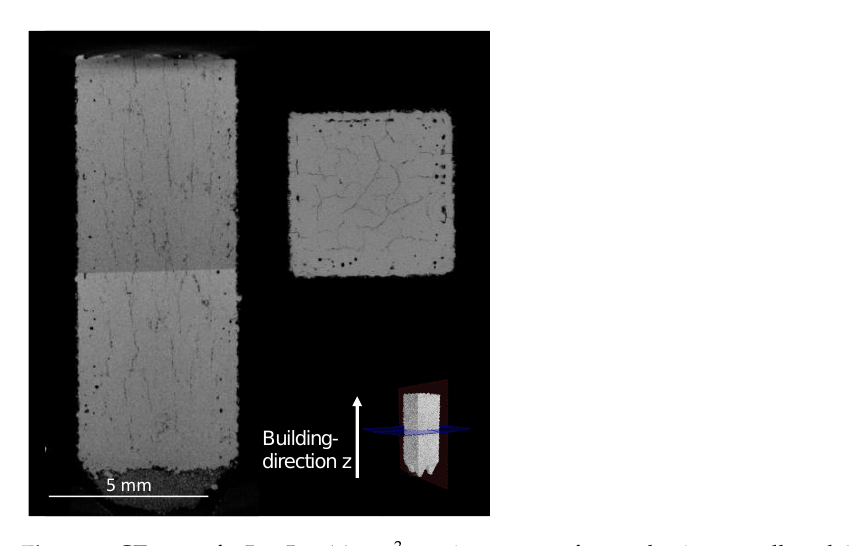
Figure 2. CT scan of a 5 × 5 × 16 mm 3 specimen, manufactured using pre-alloyed 6182 powder.